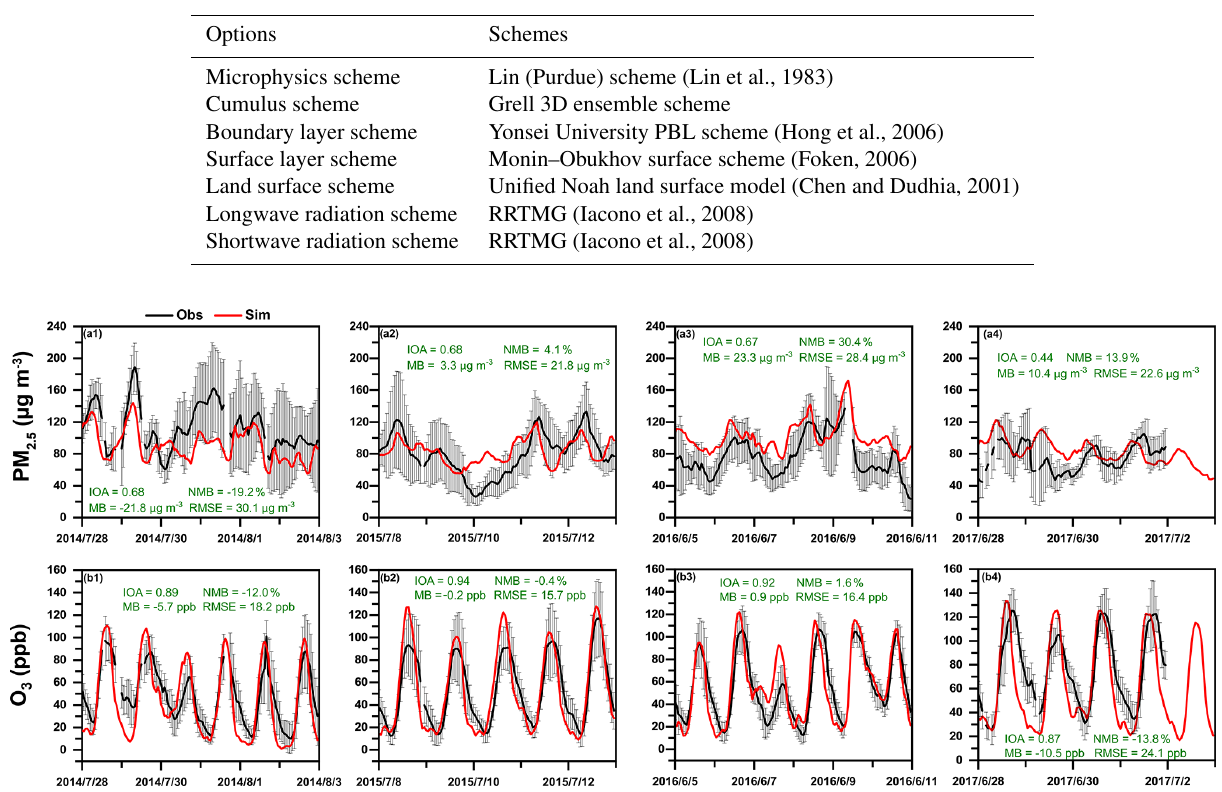
Figure 2. Time series of observed (black) and simulated (red) hourly surface (a) PM 2 . 5 and (b) O 3 concentrations averaged over the 32 observation sites in Beijing, Tianjin, and Baoding during 28 July to 3 August 2014 (Episode1; a1 and b1 ), 8–13 July 2015 (Episode2; a2 and b2 ), 5–11 June 2016 (Episode3; a3 and b3 ), and 28 June to 3 July 2017 (Episode4; a4 and b4 ). The error bars represent the standard deviations. The calculated index of agreement (IOA), mean bias (MB), normalized mean bias (NMB), and root mean square error (RMSE) are also